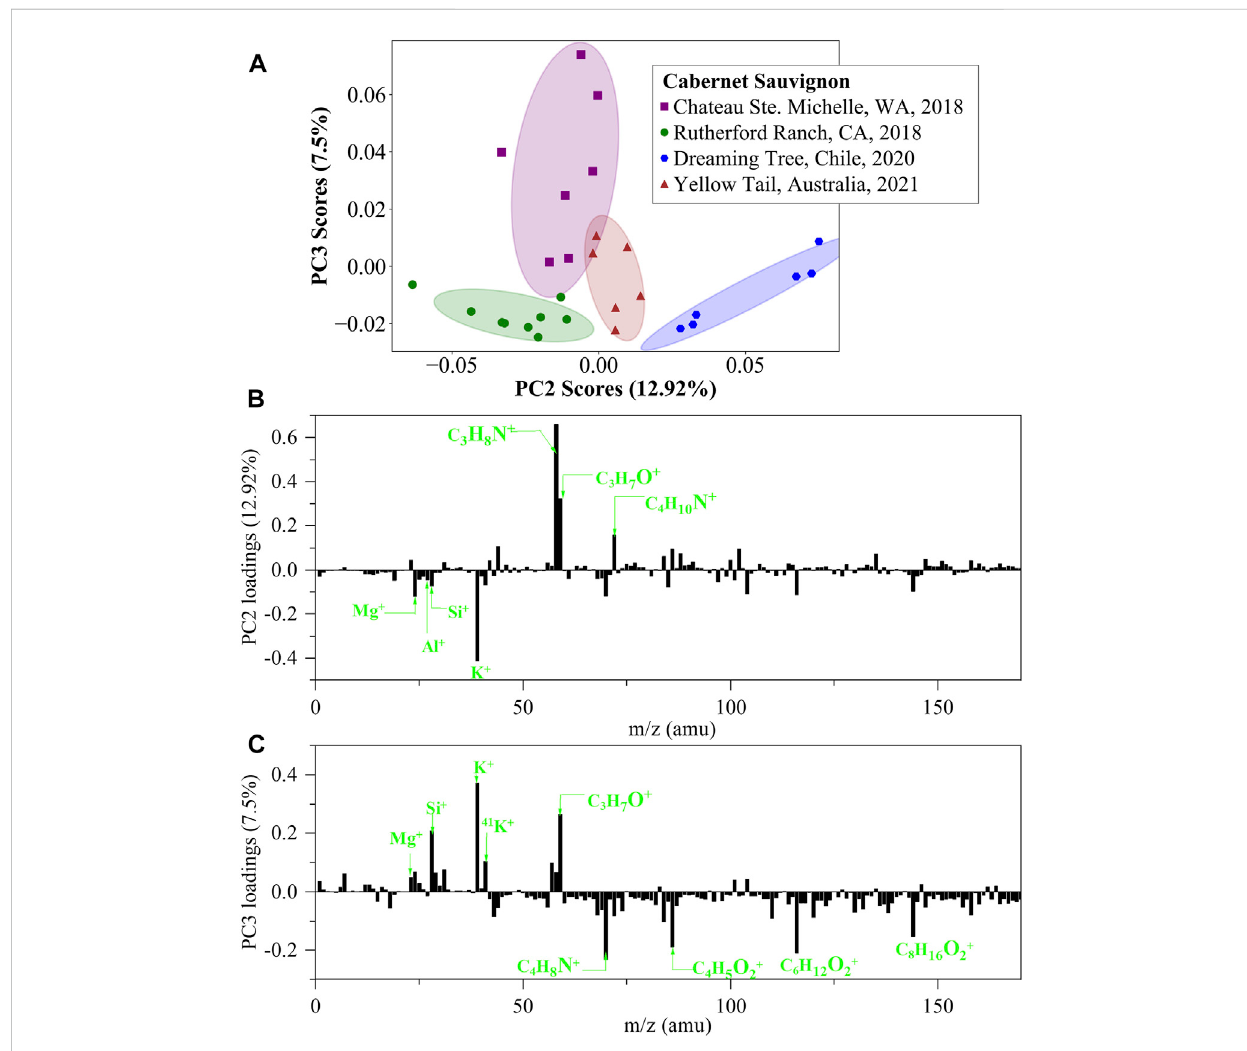
PCA analysis of in situ liquid SIMS spectra from the four Cabernet Sauvignon wines in positive ion mode. (A) Scores plot of the second principal component (PC2) versus the third principal component (PC3) from the spectra of in situ liquid SIMS. (B) Corresponding loadings plot of PC2 and (C) Corresponding loadings plot of PC3. Note: no signi fi cant loadings were observed over m/z